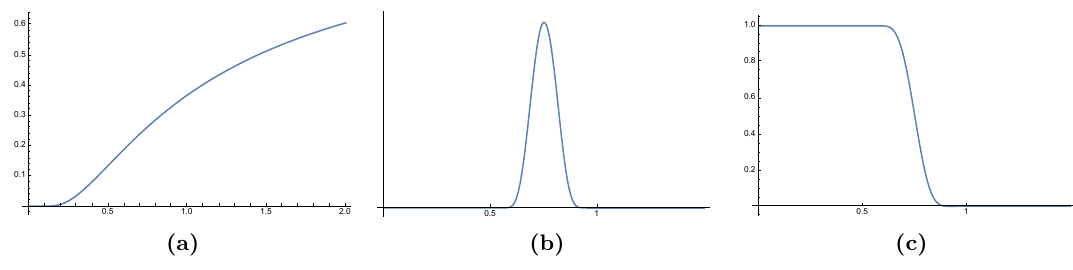
Figure 3. (a) Function X 0 ( t ) for r = 1 ; (b,c) The corresponding functions X 1 ( t ) and X ( t )